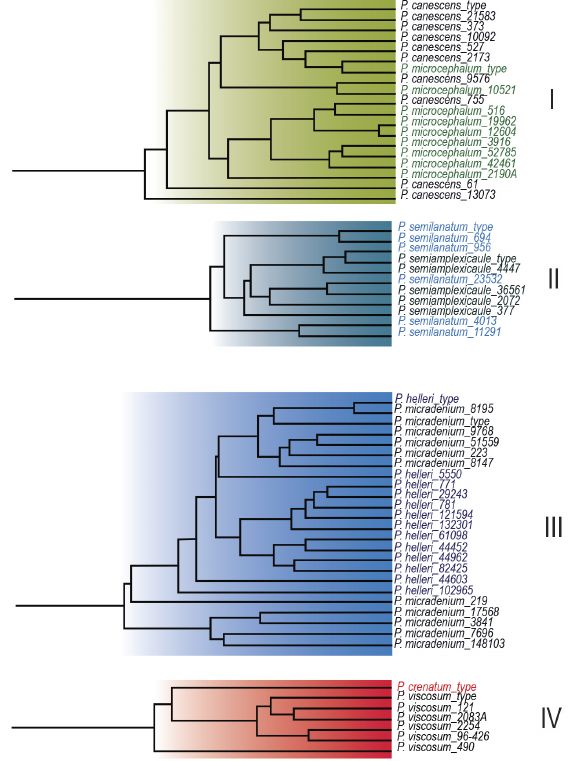
Figure 1b. Groups I-IV of the UPGMA cluster analysis of the North American species of Pseudognaphalium (continued from Fig. 1a). I: P. canescens and P. microcephalum ; II: P. semilanatum and P. semiamplexicaule ; III: P. helleri and P. micradenium ; IV: P. crenatum and P. viscosum